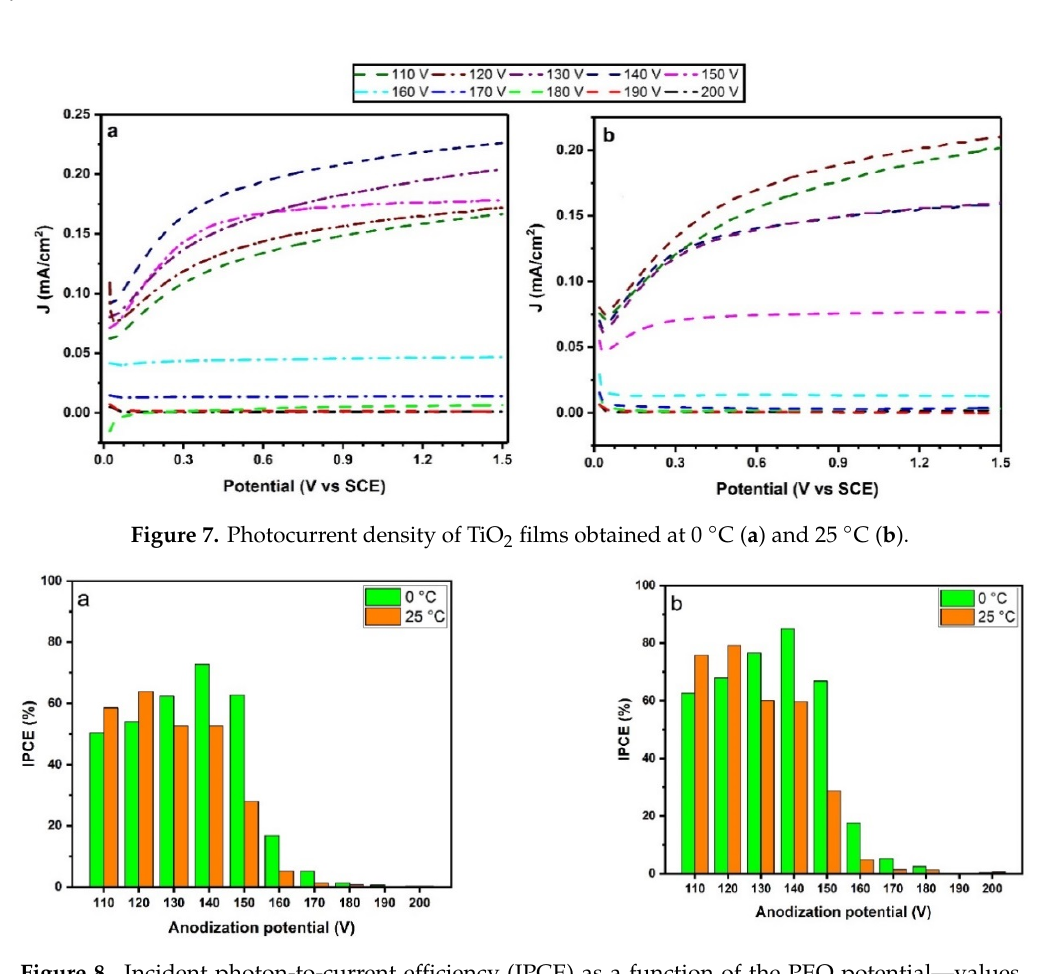
Figure 8. Incident photon-to-current efficiency (IPCE) as a function of the PEO potential—values calculated under polarization at 0.6 V vs. Standard Calomel Electrode (SCE) ( a ) and at 1.5 V vs. SCE ( b ).